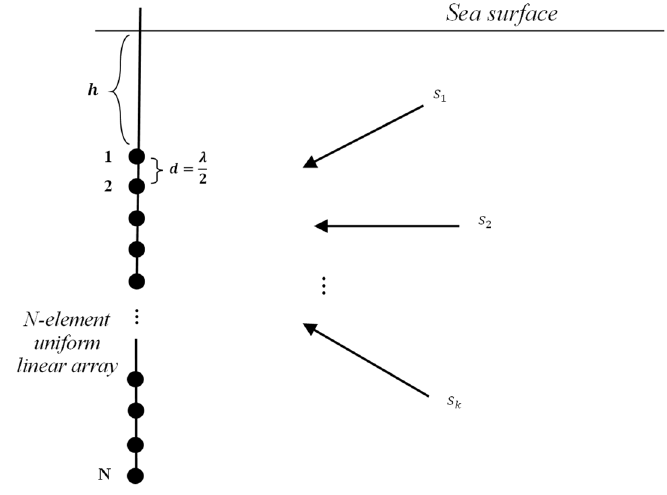
Figure 1. Received model of N-element uniform linear array.